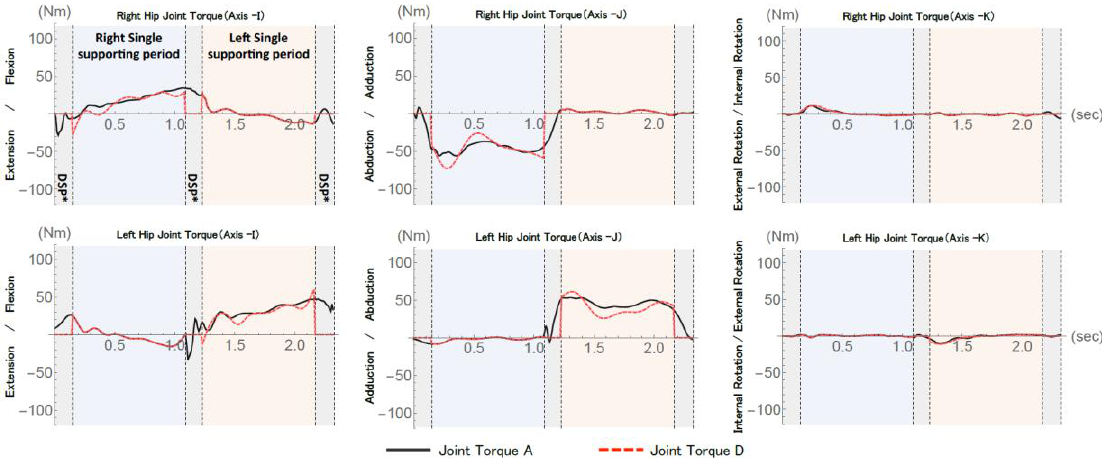
Figure 4. Comparison of Hip joint torque. * DSP: Double supporting